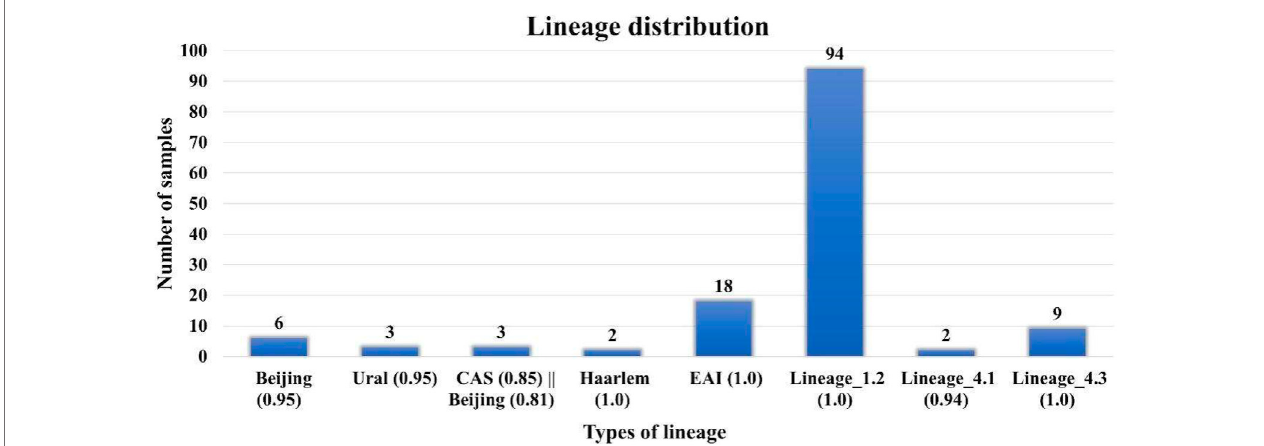
FIGURE 2 | Lineage distribution of 137 samples where Lineage 1 (Indo-Oceanic) found in the Indian Ocean; Lineage 2: East Asia, including Beijing; Lineage 3 East Africa and India (Central Asian (CAS)/Delhi); Lineage 4 (Euro-American) Africa, Europe, and America, American – Mediterranean (LAM), Haarlem, X type, and T